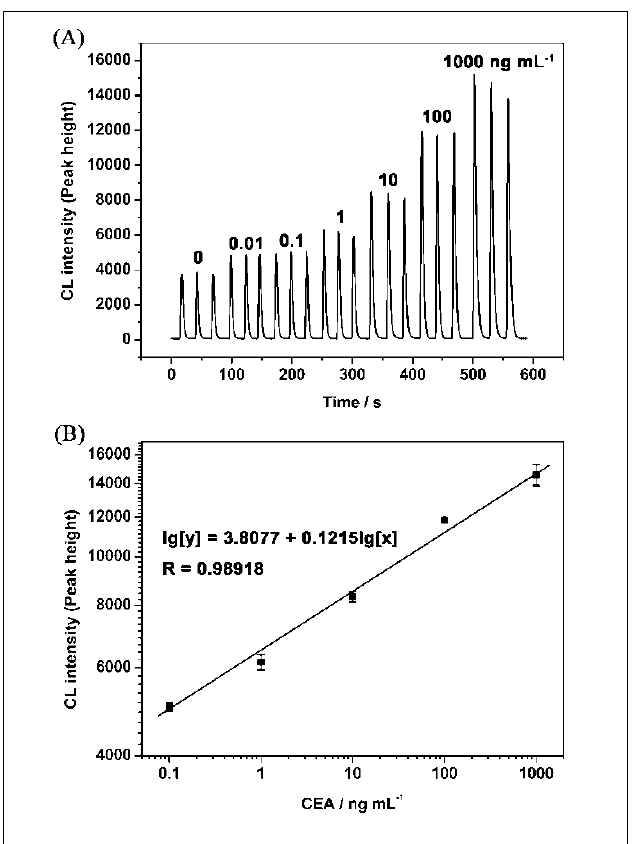
Figure 5. Relationship between the concentration of CEA and CL intensity after the immunogold